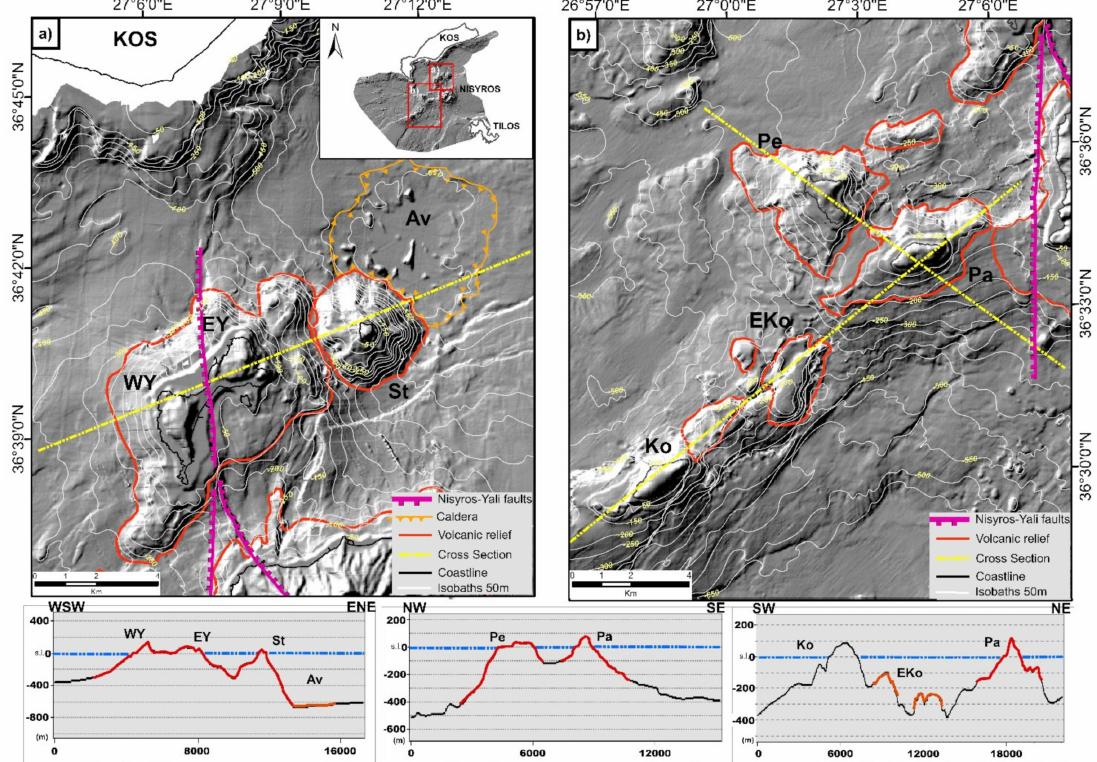
Figure 7. ( a ) The volcanic relief (in red) of Yali and Strongyli islets is shown in the topographic profile of Yali-Strongyli where the volcanic structures of the Western Yali (Wy), Eastern Yali (Ey), Strongyli (St) and Avyssos caldera (Av) are depicted and ( b ) the volcanic relief (in red) of Pergousa (Pe) islet, Pachia (Pa) islet and East Kondeliousa (EKo) submarine volcanic dome (EKo) and the relief of Kondeliousa islet (Ko) are also depicted in topographic